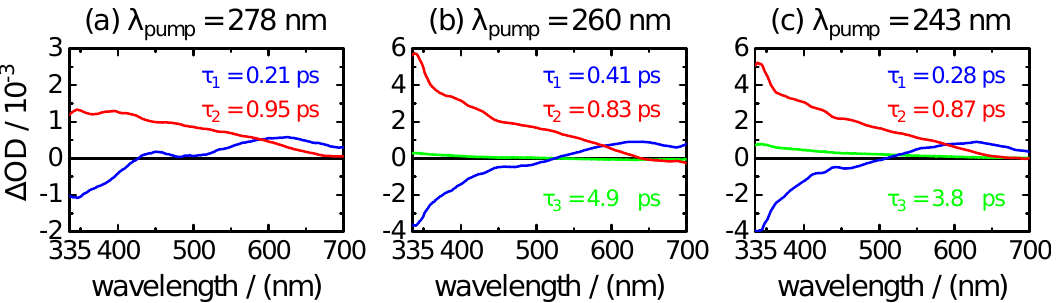
Figure 10. Decay time-associated difference spectra (DADS) vs. probe wavelength for XMP − after excitation at: ( a ) λ pump = 278 nm; ( b ) λ pump = 260 nm; and ( c ) λ pump = 243 nm. τ 1 : blue; τ 2 : red; τ 3 :